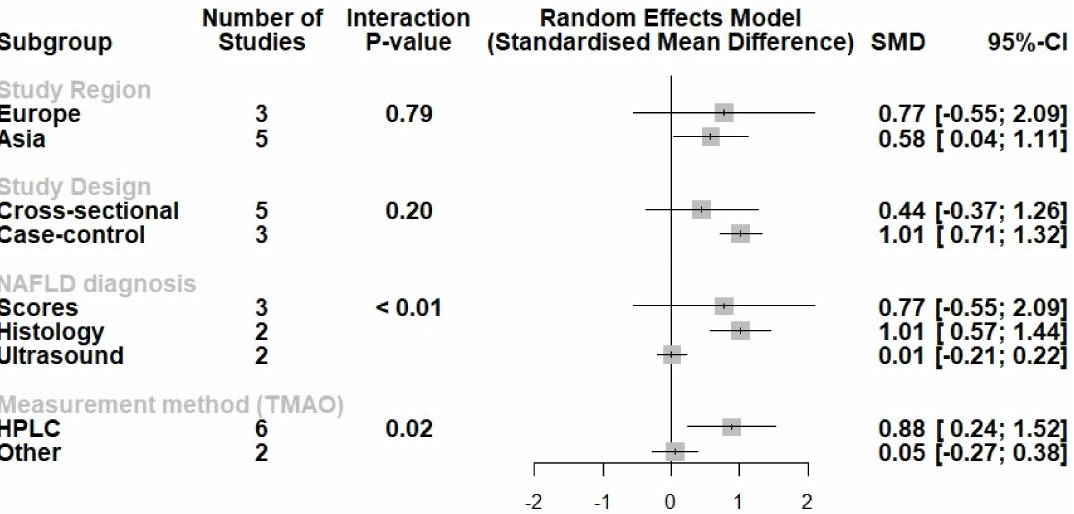
Figure 4. Subgroup analysis displaying no differences according to the study design or study region. Effect sizes were pooled according to the random effects model and the subgroup analysis followed the fixed-effects (plural) model. Results are expressed as standardized mean difference (SMD) with horizontal error bars denoting the 95% confidence intervals